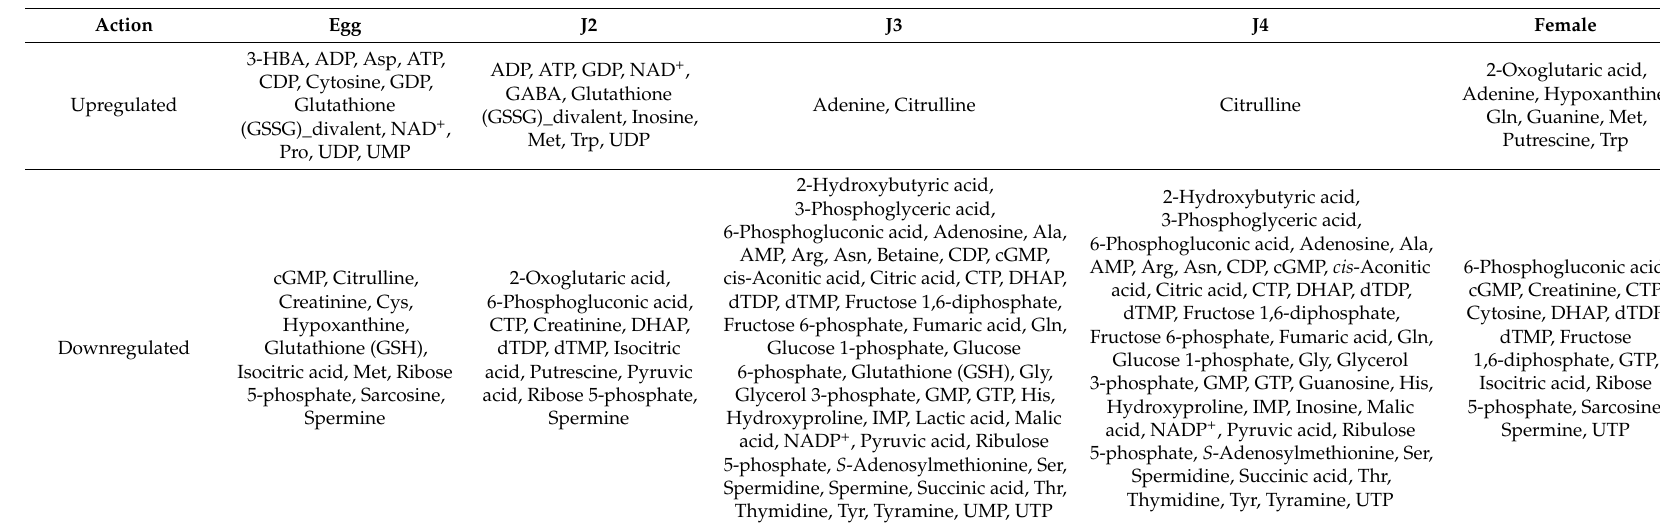
Table 3. Stage-wise highly up and down-regulated metabolites of Meloidogyne